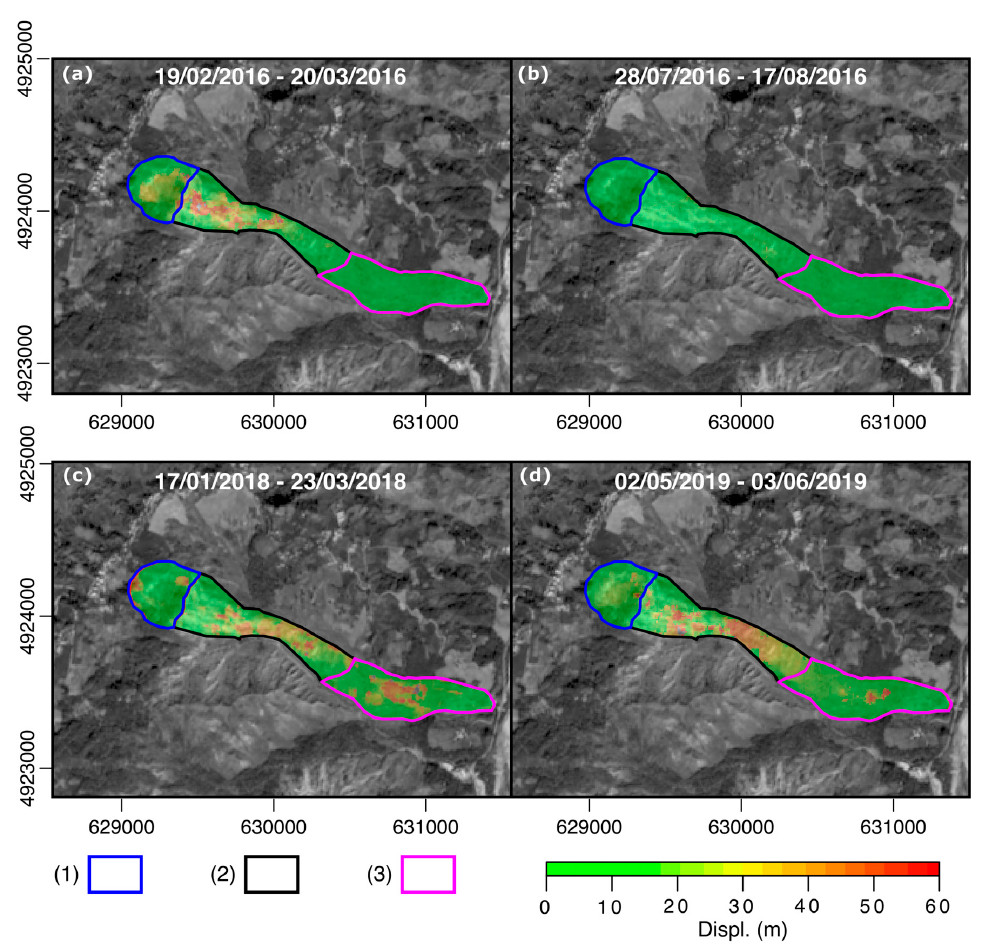
Figure 7. Activity stages of the Ca’ Lita landslide. ( a ) March 2016 reactivation; ( b ) Summer 2016 suspended phase; ( c ) March 2018 reactivation and ( d ) Spring 2019 reactivation. (1) Head zone. (2) Upper track zone. (3) Lower track zone. Grid coordinates: WGS84/UTM32N (EPSG: 32632). The results of the DIC displ time-series extraction with the 60 × 60 m computation matrices centred on the median coordinates values of each GNSS rover are presented in Figure 8. An issue with the construction of the DIC displ time-series is that errors can cumulate at each time step resulting, in the long-term, in unreliable cumulated displacement values. In order to assess this issue, prior to DIC displ time-series extraction, we have filtered the DIC movement maps by using different minimum displacement thresholds ranging from 1 to 10 m. This has allowed us to generate different DIC displ time-series, at variable filtering thresholds, for slope movements around the GNSS (Figure 8). Results show, qualitatively, that the higher the displacement threshold is, the better is the fit between the DIC displ and the GNSS displ time-series. For instance, by adopting a displacement threshold of ≥ 10 m (i.e., the pixel size of Sentinel data), the DIC displ over the entire period of analysis reach totals of around 290 m in the upper track zone, 90 m in the lower track zone and 20 m in the head zone, which are quantitatively comparable with GNSS displ results. On the other hand, by using minimum displacement thresholds ˂ 10 m (i.e., sub-pixel accuracies), the DICd ispl time series tend to overestimate movements, as errors are cumulated over time. In the high mobility GNSS rovers ROV1 and ROV2, the offset between the DIC displ and the GNSS displ time-series becomes quantitatively significant for minimum displacement thresholds lower than 5 to 7 m. In the low mobility ROV3, the discrepancy is already evident for minimum displacement thresholds lower than 8 m.